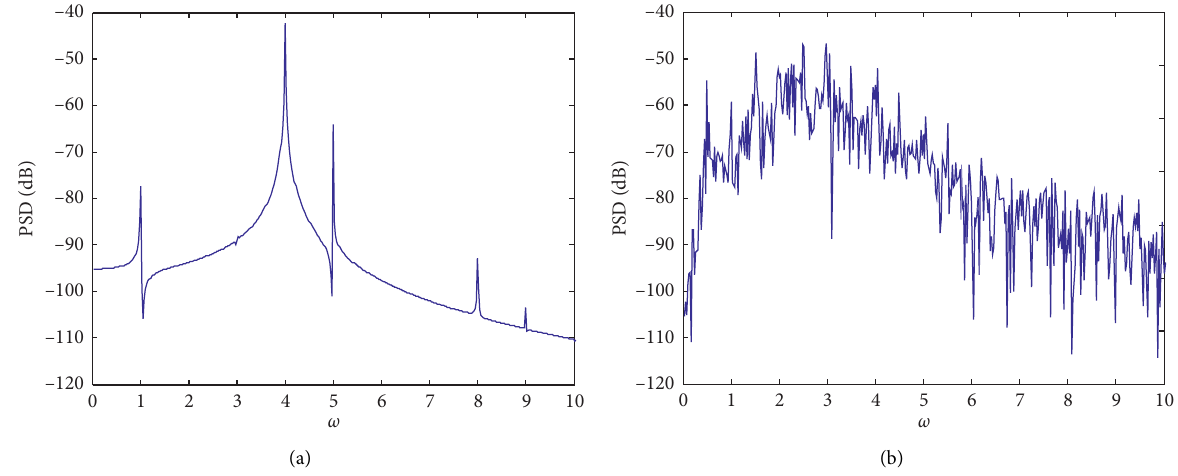
Figure 1: Comparison of line spectrum structure before (a) and after (b)